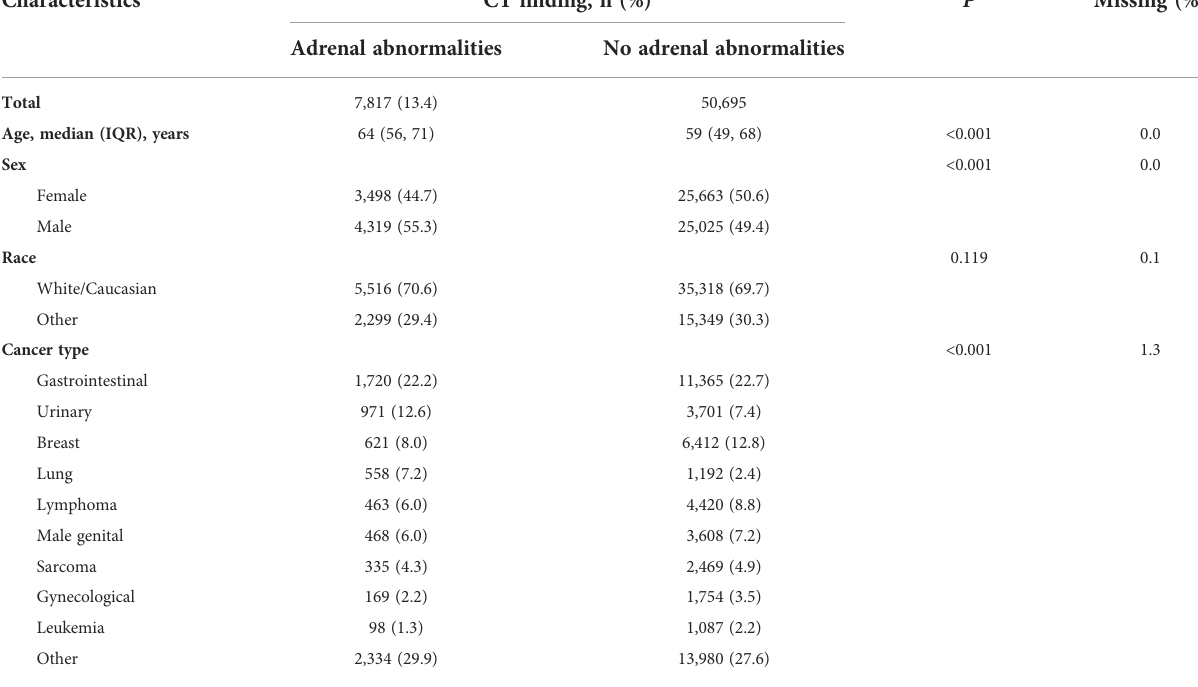
TABLE 1 Demographics and clinical characteristics of the patient cohort.